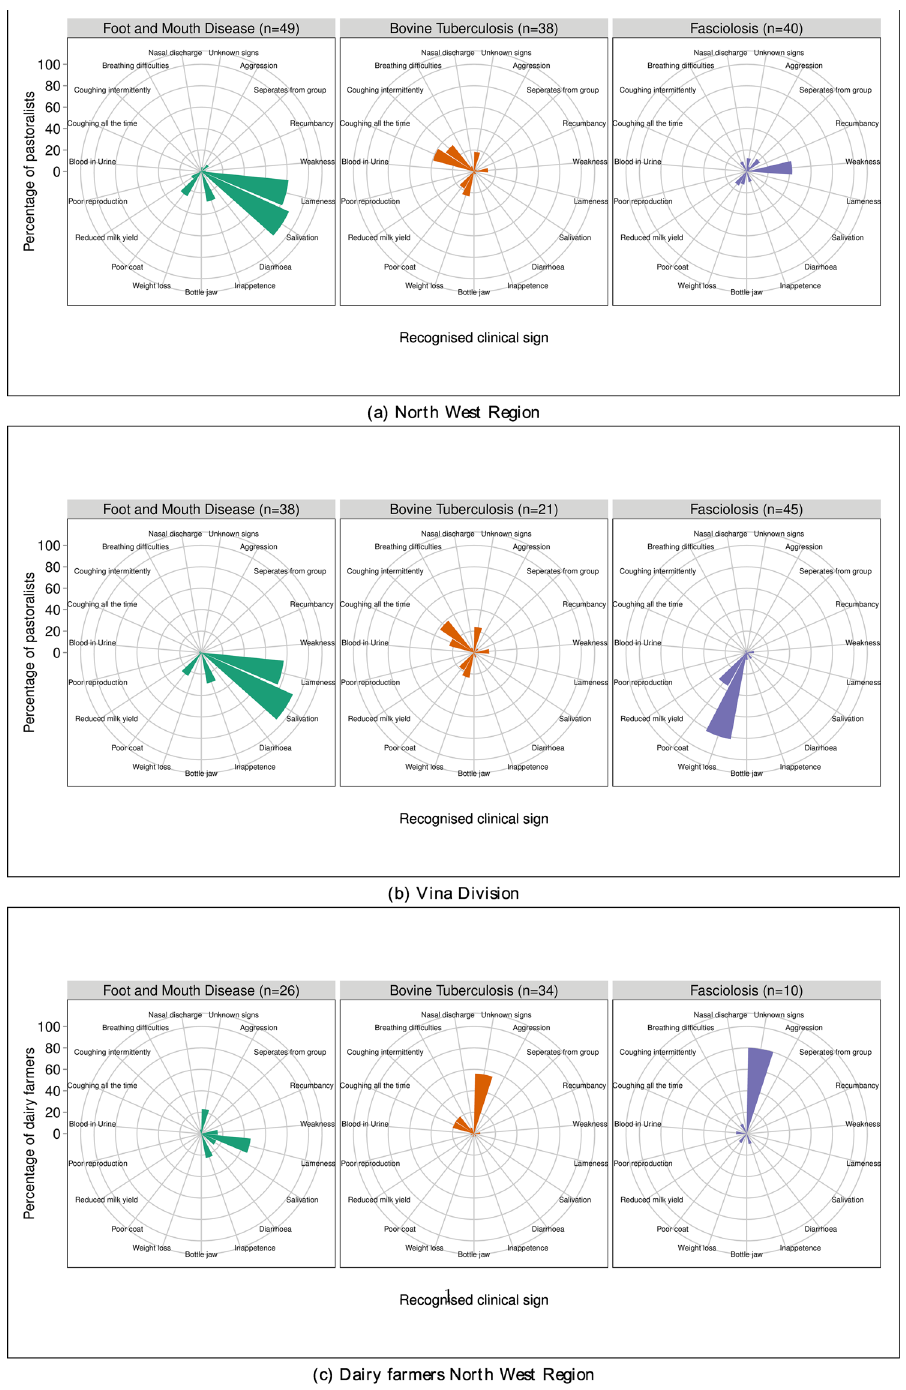
Fig 2. Frequency of clinical signs identified for bovine tuberculosis and fasciolosis. Y-axis intervals are for every 20% of cattle keepers “ aware ” of the